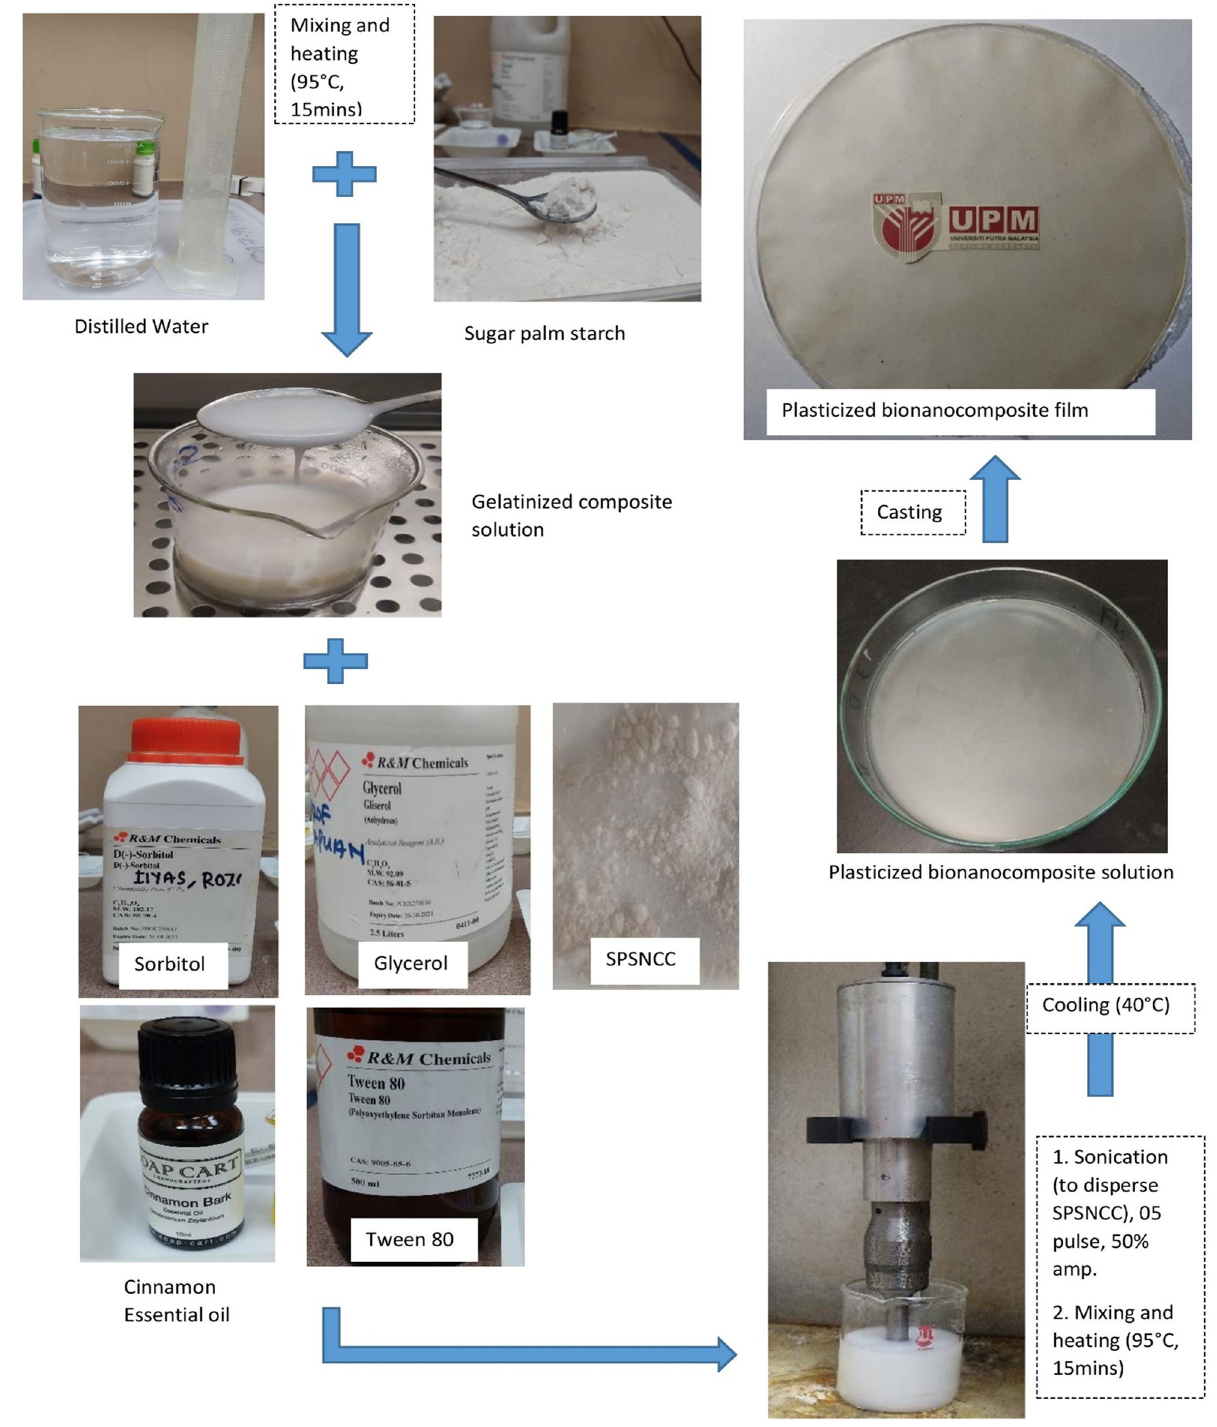
Figure 1: Processing fl owchart of the bionanocomposite fi